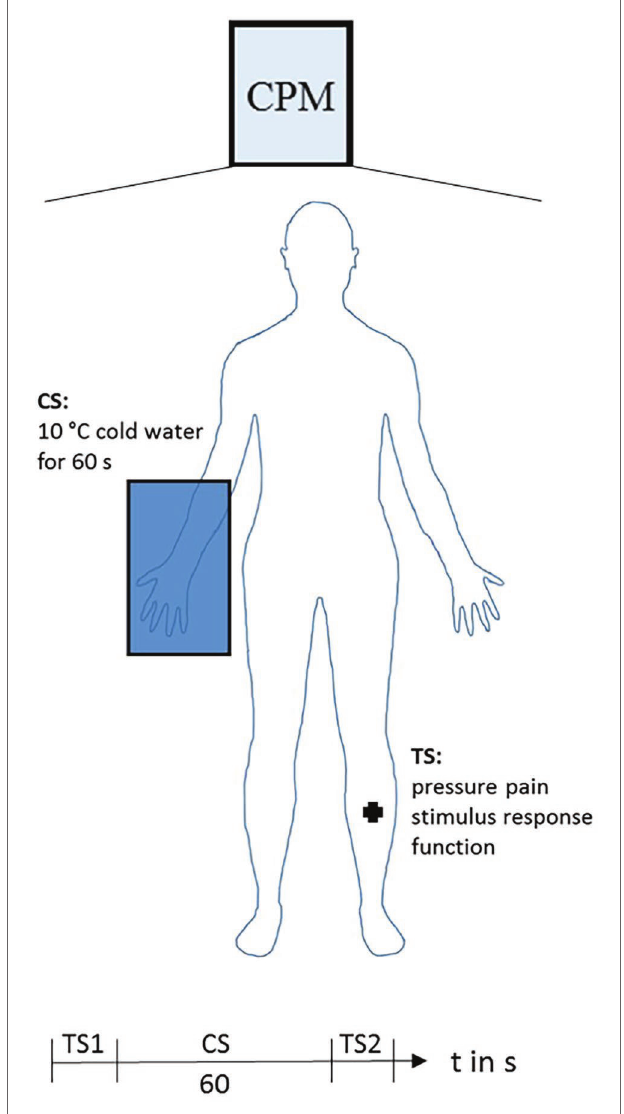
FIGURE 4 | Conditioned pain modulation paradigm. Test stimulus (TS): stimulus-response function of painful pressure at left leg. Conditioned stimulus (CS): 10 ° C cold water immersion of the right hand for 1 min. Pain was rated after 45 s of the CS on a VAS ranging from 0 = no pain to 100 = unbearable pain. Sequence of consecutive applied stimuli: first test stimulus (TS1), CS, second test stimulus